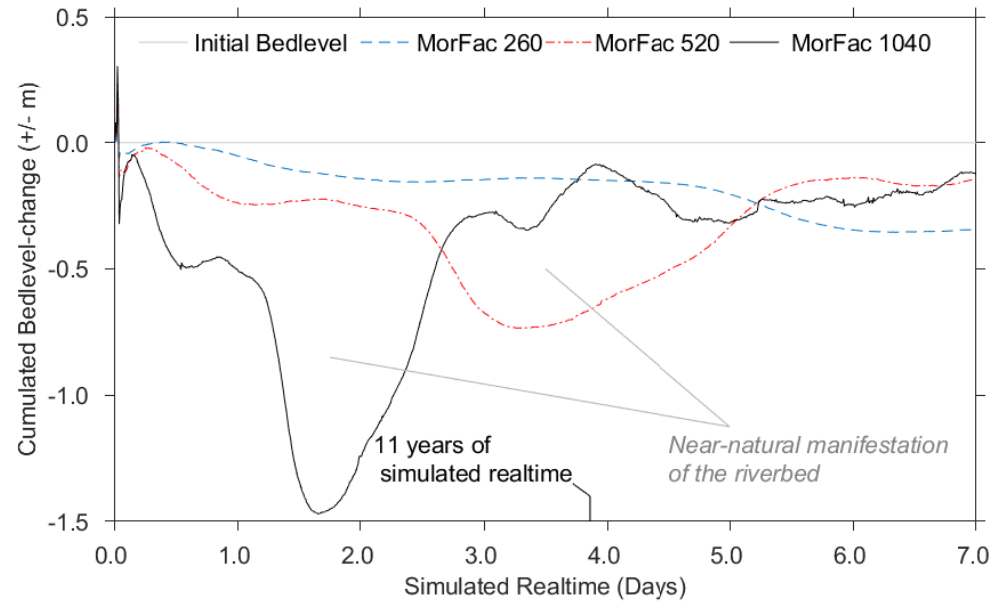
Figure 9. Cumulated sedimentation/erosion over time for three different values of the MorFac.